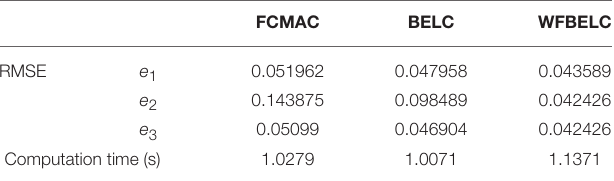
TABLE 2 | Results for Chua’s chaotic circuit. FCMAC